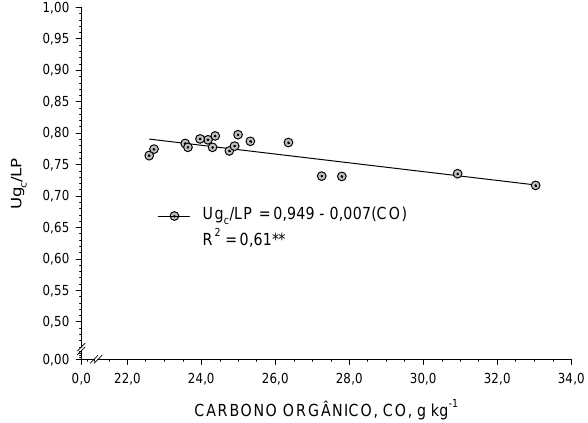
Figura 5. Razão entre a umidade crítica para compactação (Ug ) e o limite de plasticidade c (LP), considerando o teor de carbono orgânico do solo de um Nitossolo Vermelho distrófico (** modelo ajustado é significativo a p ≤≤≤≤≤ 0,01 pelo teste